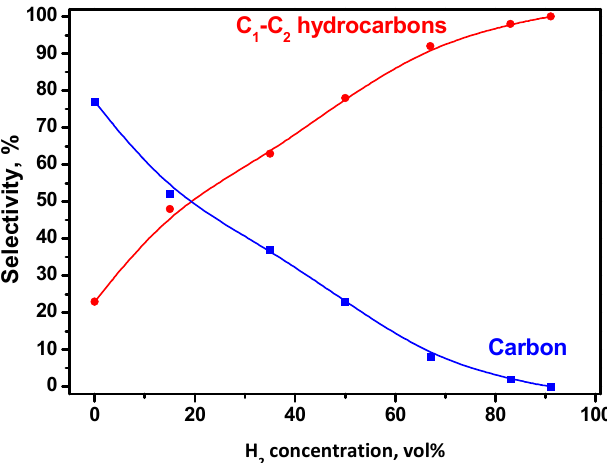
Figure 5. Effect of the hydrogen concentration in the H 2 /C 2 H 4 Cl 2 reaction mixture on the selectivity of Ni/Al 2 O 3 catalyst towards carbon and C 1 -C 2 hydrocarbons. The reaction temperature is 500 °C.